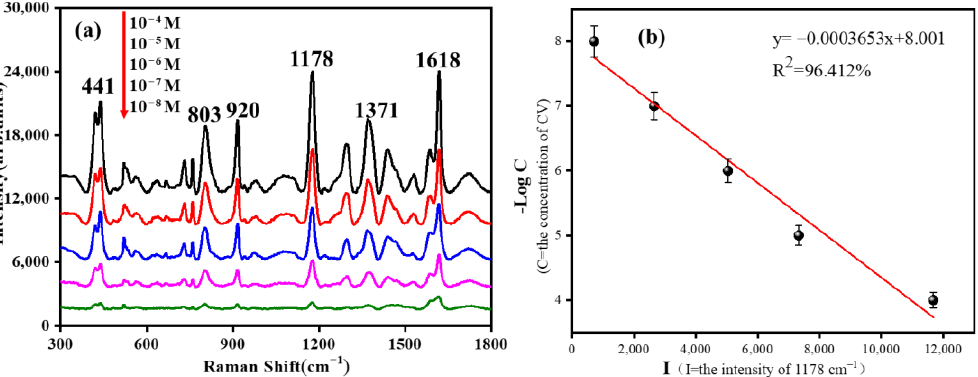
Figure 5. ( a ) SERS spectra of CV with different concentrations on GO/Fe 3 O 4 @Au MNPs; ( b ) SERS peak strength linear fitting curve of different concentrations of CV at 1178 cm − 1